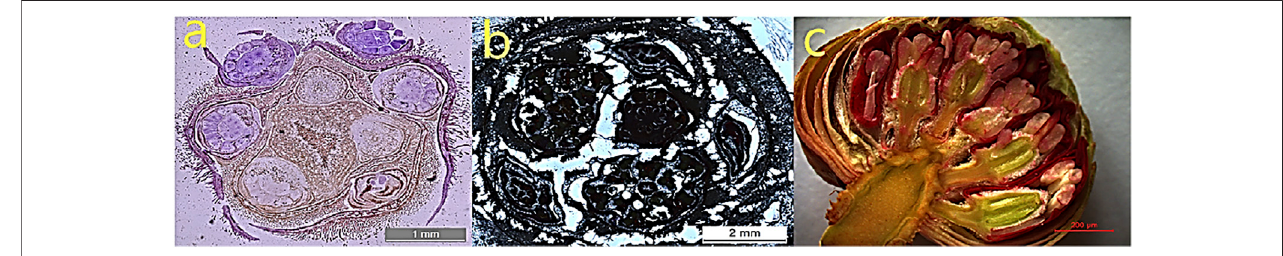
FIGURE 2 | Histological assay through light microscopy showing Rhododendron delavayi Franch. dormant fl oral bud initiation in paraf fi n section and freehand longitudinal section. (A) Cross-section (1 mm) of buds collected on 1 ) 1st September, and 2 ) 29th October, containing the loose tissue structure due to the large-sized fl oralbud,makingitchallengingtotaketheparaf fi nsection (B) partoftheimage(2 mm)showingspreadoutofstain. (C) Thelongitudinalsection(200 µM)ofthesampled bud depicts the fl orets at the stage of complete differentiation of fl ower buds, which then gradually enters the dormancy